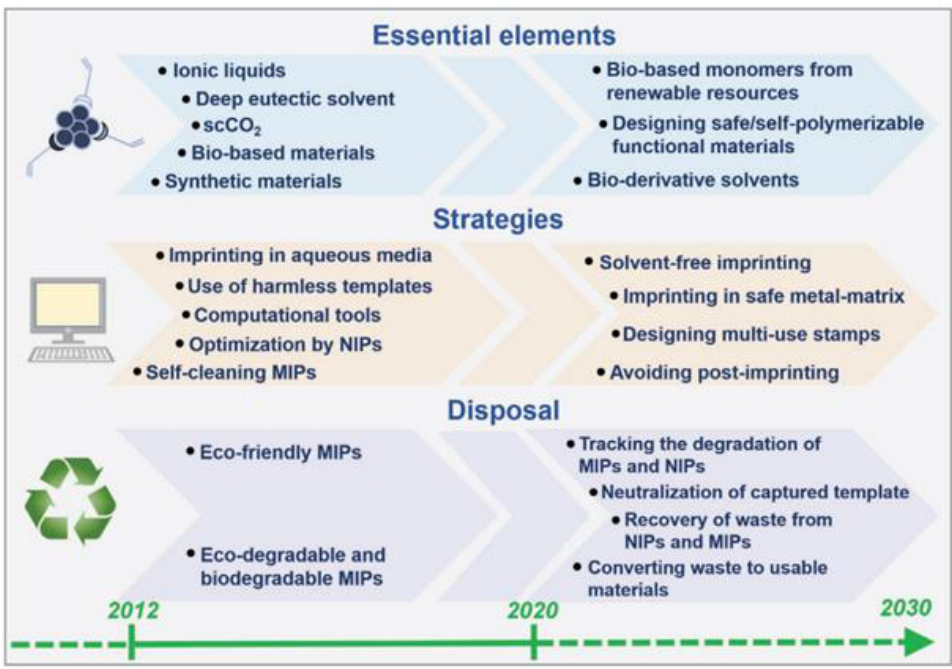
Figure 8. “Greenificated” molecular imprinting technology road map from 2012 to 2030. (Reprinted from ref. [132]. Reprinted with permission from Ref. [132]. Copyright 2021 John Wiley and Sons).